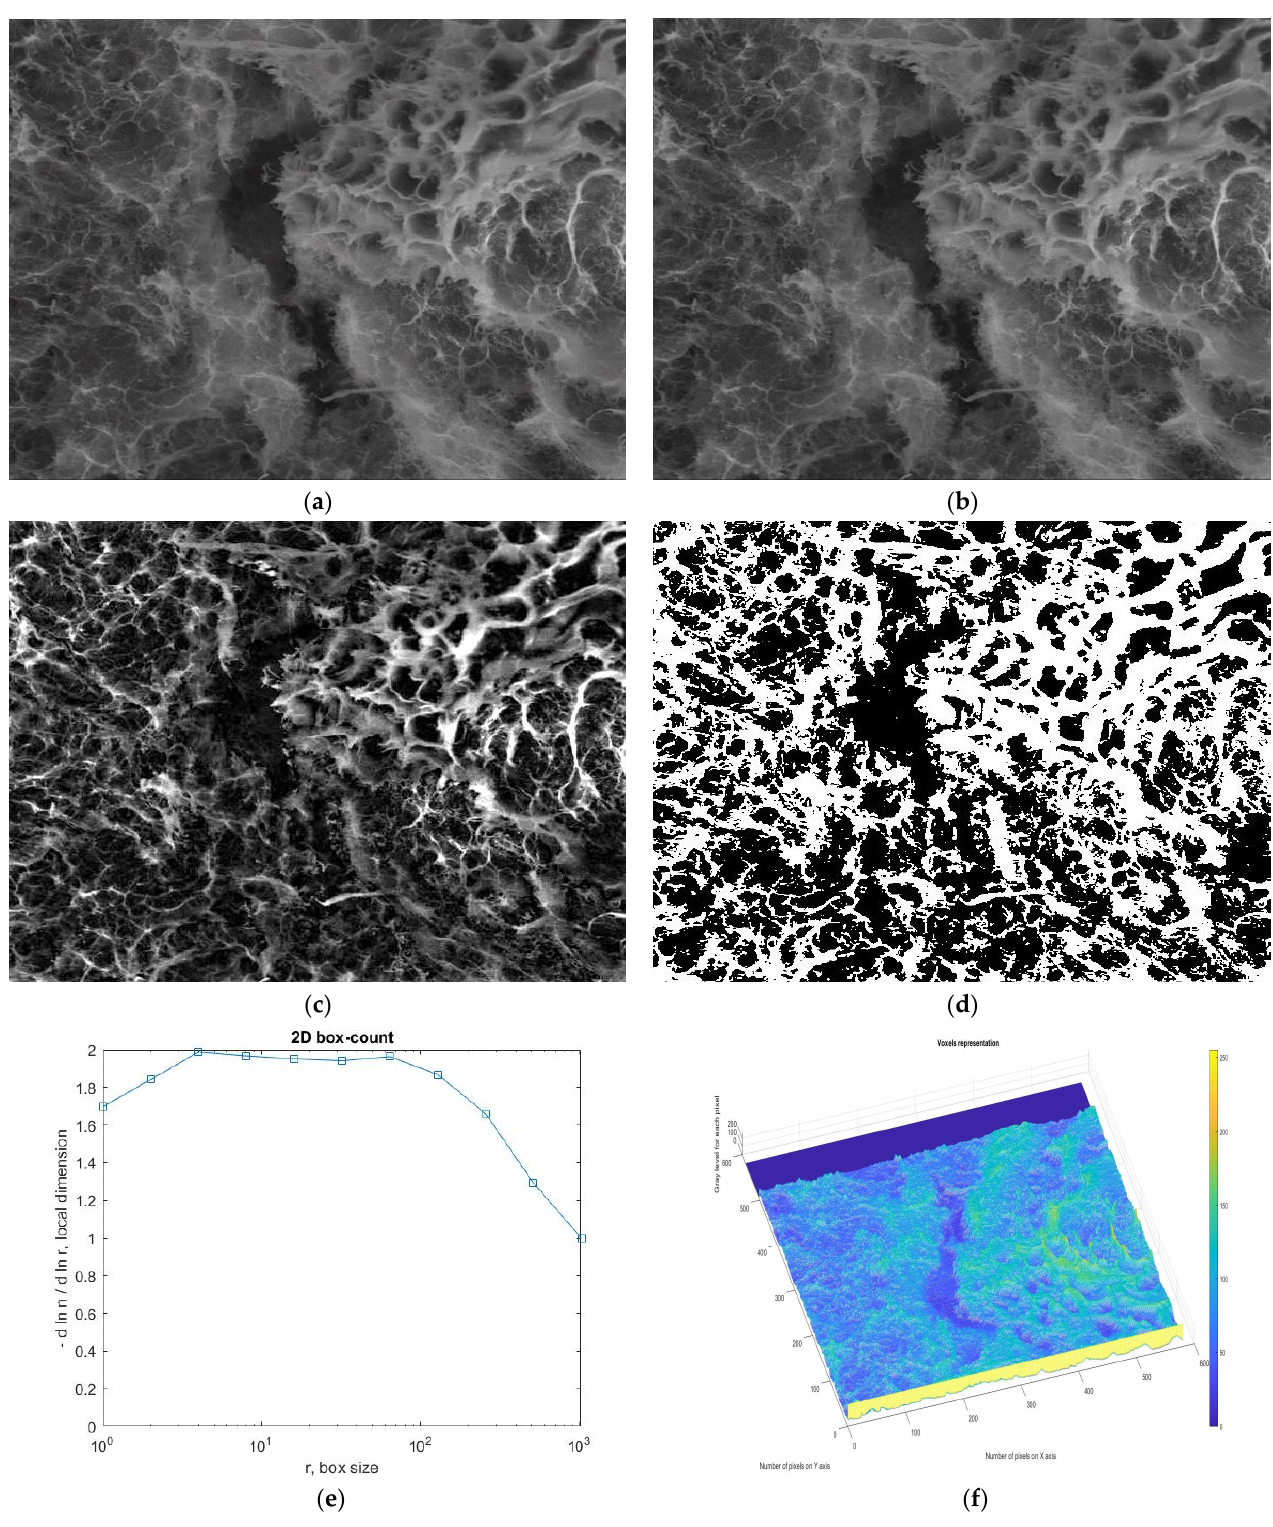
Figure 8. Fractal investigation of image A: ( a ) Black and white version of image A, ( b ) Grayscale version extracted from the background, ( c ) Grayscale version with luminance, ( d ) Binary version, ( e ) Box-count representation, ( f ) Voxel representation